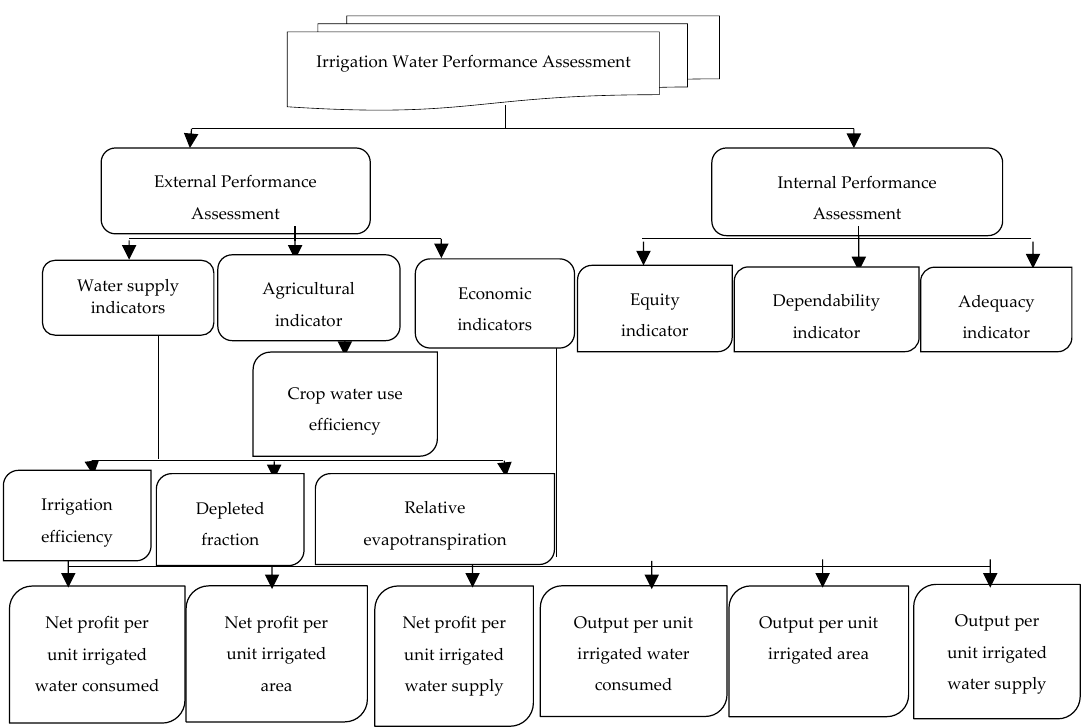
Figure 2. Schematic diagram of the framework of the irrigation water performance assessments.